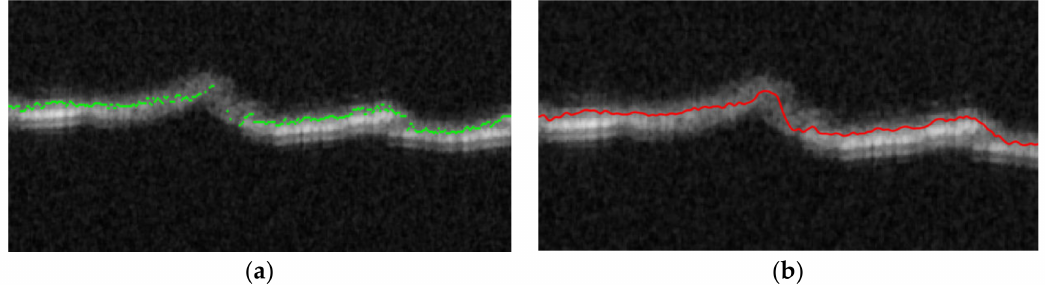
Figure 7. Enlarged fragment of example B-scan of Cordura with an Ag layer: ( a ) with the detected set of edge voxels; ( b ) with a continuous edge approximated with